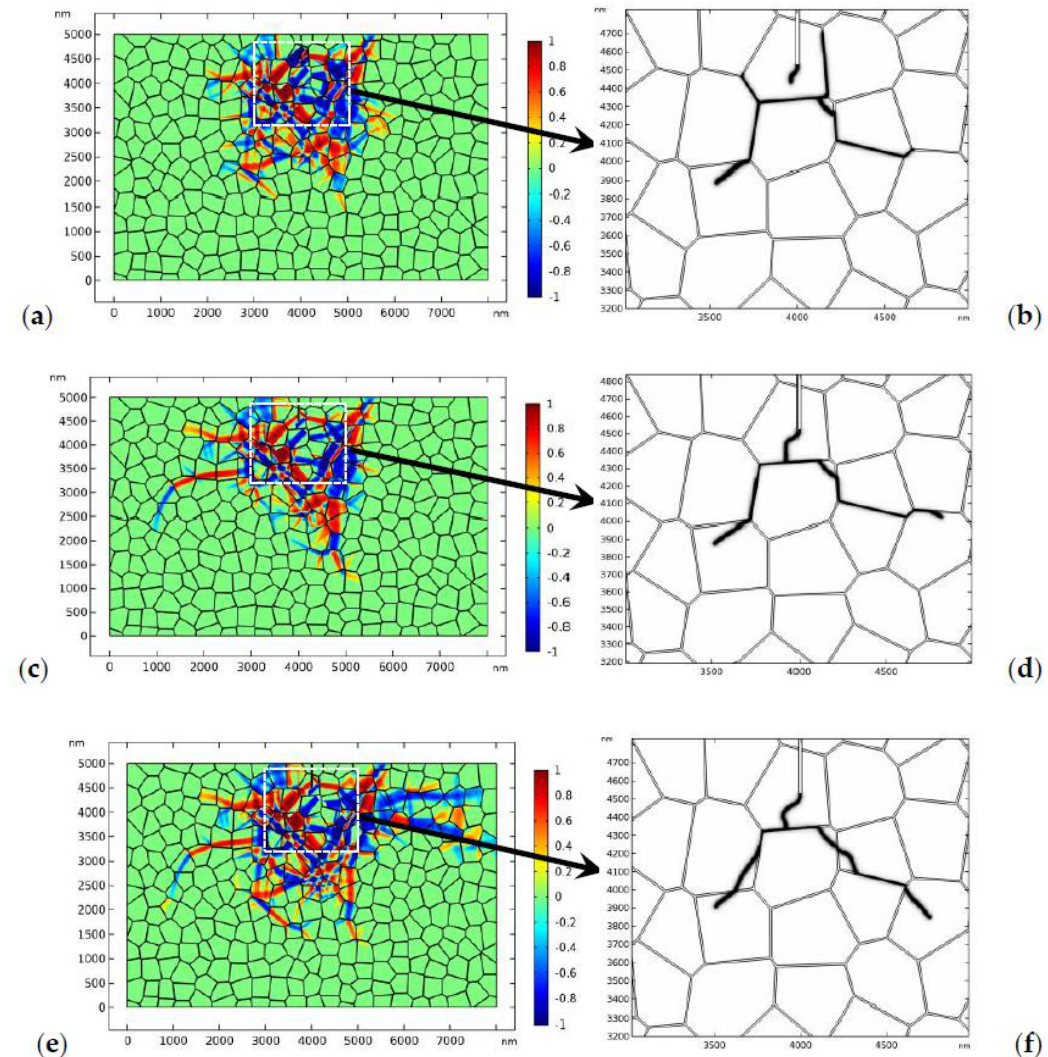
Figure 17. The evolution of the phase transformation and crack propagation in TZP (crystal orientation I) with a “weak” GB where the fracture toughness of the bulk grains is 1.2 MPa m: The phase pattern and crack propagation path under di ff erent applied loads. ( a , b ) The load is 160 MPa. The phase patterns and the topology of crack propagation correspond to 3.6 µ s. ( c , d ) The load is 170 MPa. The phase patterns and the topology of crack propagation correspond to 2.8 µ s. ( e , f ) The load is 180 MPa. The phase patterns and the topology of crack propagation correspond to 2.2 μs .